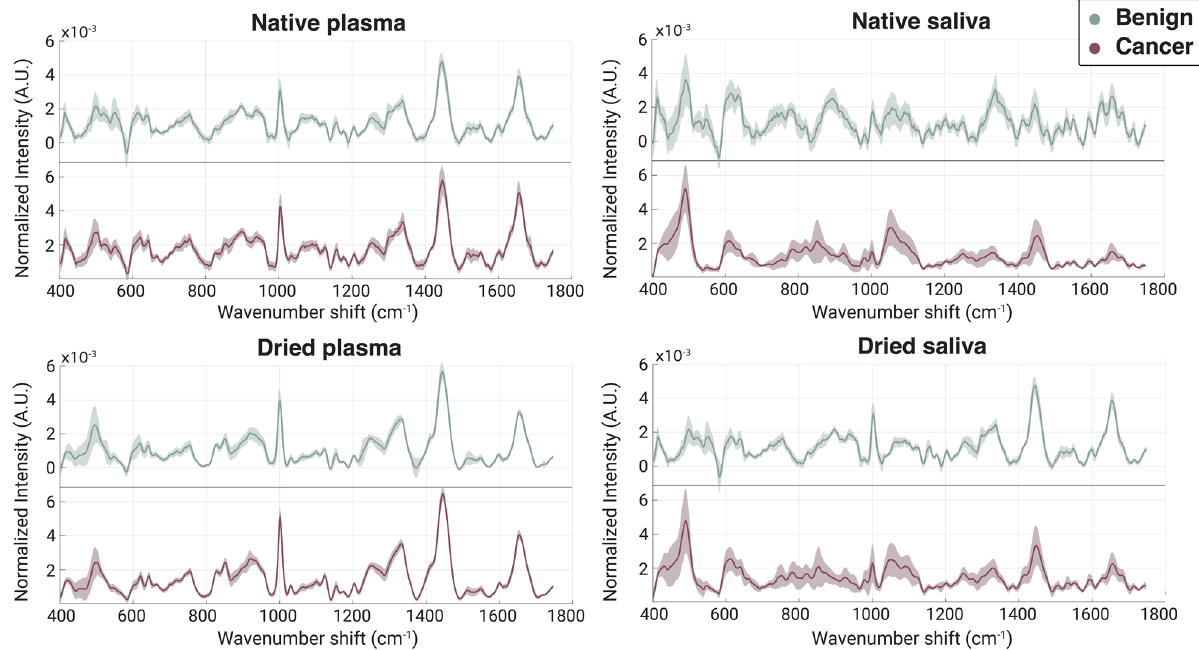
Figure 2. Global averages and standard deviations for cancerous samples (purple) and control samples (green) of the plasma (left) and saliva (right) in both a native (top) and dried (bottom) state. The native samples had a higher degree of standard deviation than the dried samples, indicating there was more heterogeneity across sample measurements.